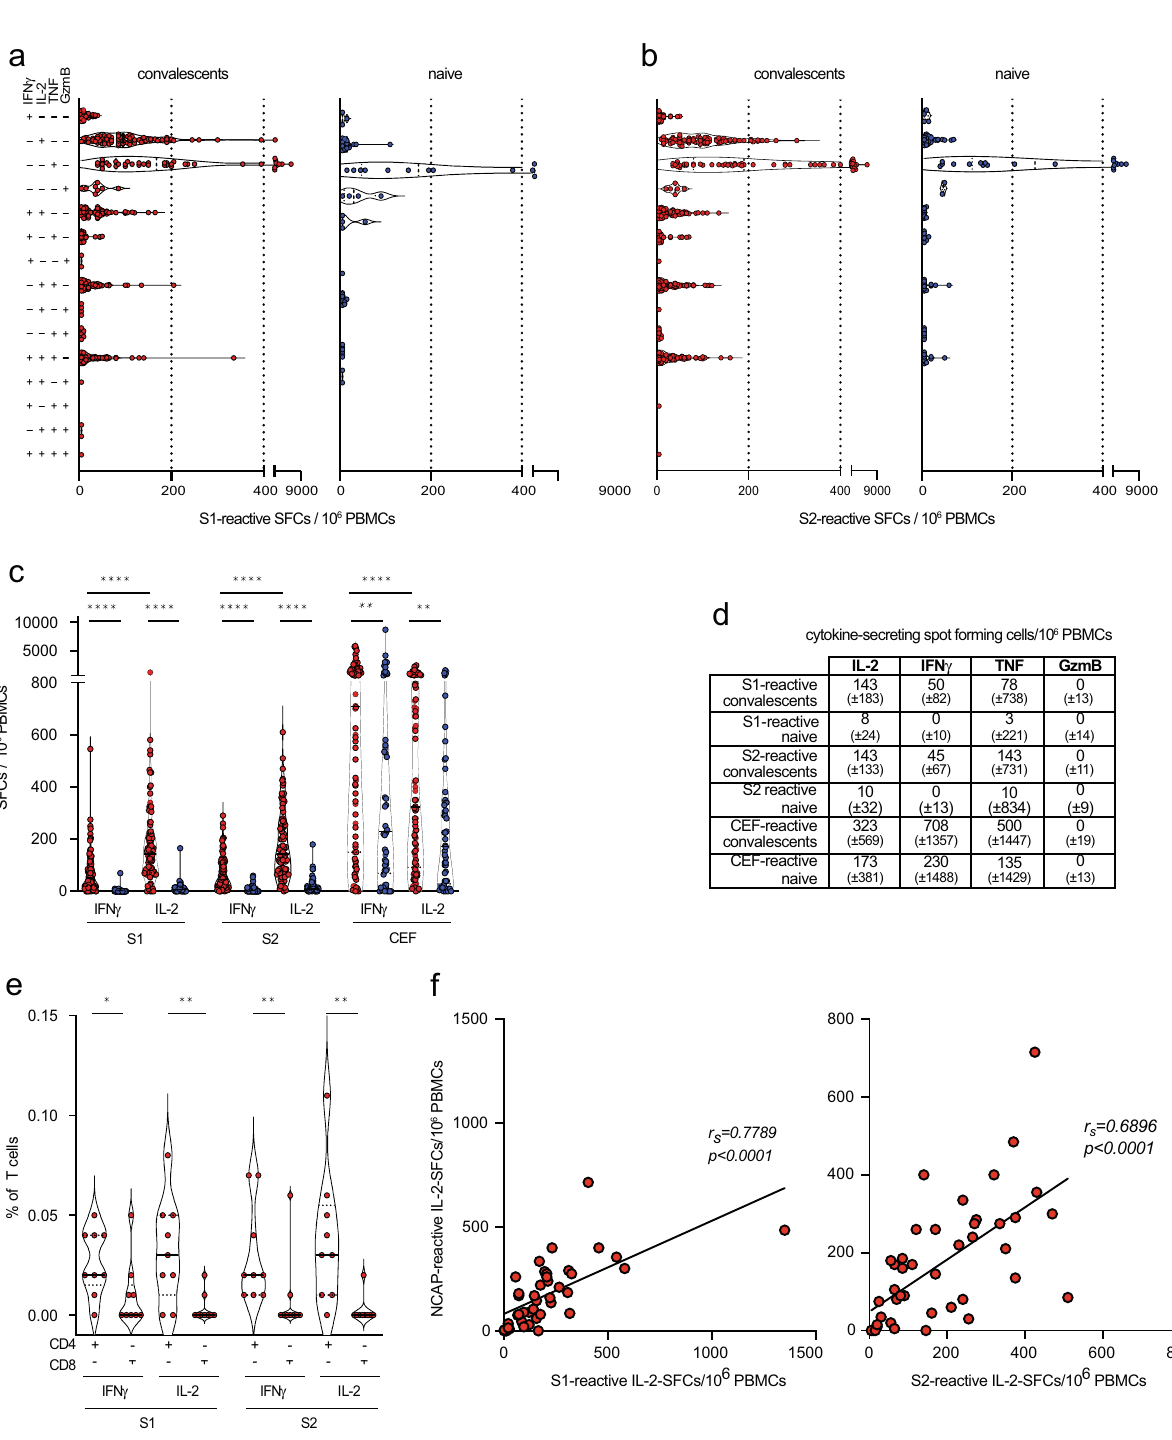
Fig. 2 IL-2 dominated spike-speci fi c CD4 T cell responses in convalescents. a , b Ex vivo Fluorospot analysis revealing the frequencies of spike-reactive mono- and polyfunctional cytokine-secreting cells (spot-forming cells/SFCs per 10 6 PBMCs from convalescents (red) or naïve individuals (blue) at month 5. c , d Total frequencies of spike-reactive cytokine-expressing cells (shown as median ± SD), CEF (CMV/EBV/Flu) peptide pool as a control in convalescents (red, n = 88) or naïve individuals (blue, n = 52). e Ex vivo detection of the frequencies of CD4 and CD8 T cells of convalescents ( n = 9) by intracellular cytokine staining and fl ow cytometry. f Correlation of the frequencies of nucleocapsid- (NCAP) and S1- and S2-reactive T cells determined by Fluorospot analysis in convalescents at month 5. Statistical analyses by two-sided Mann – Whitney, two-sided Wilcoxon signed-rank tests and Spearman correlation and linear regression ( c , e , f ); rs denotes Spearman correlation coef fi cient; * p < 0.05; ** p < 0.01; **** p <